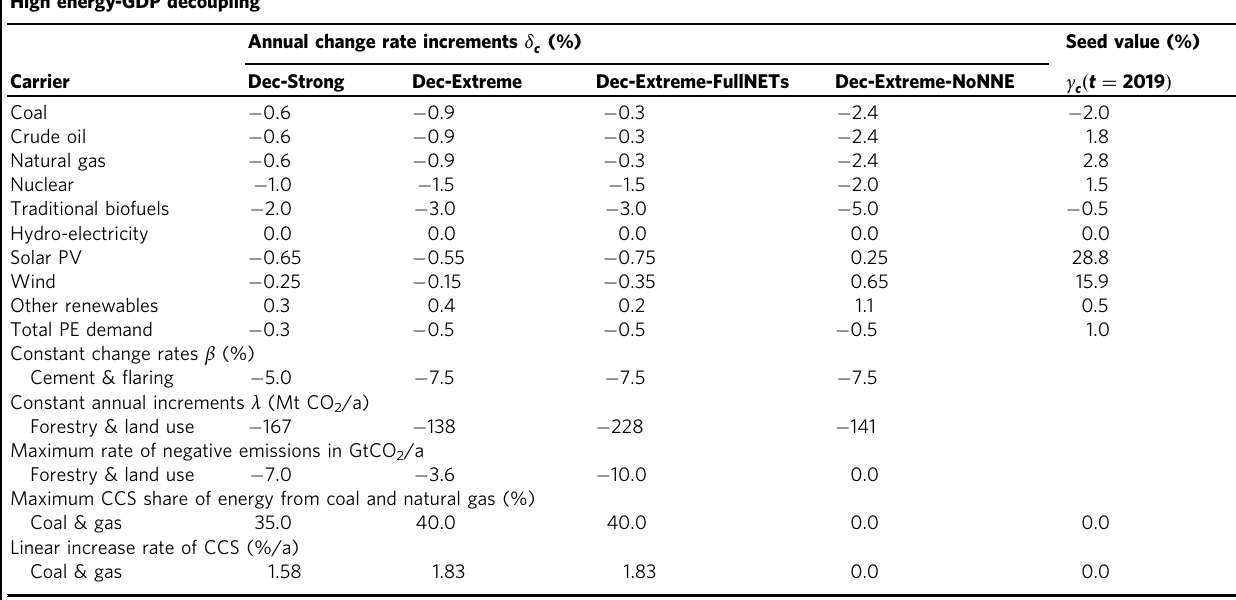
Table 6 Parameters for pathways with high energy-GDP